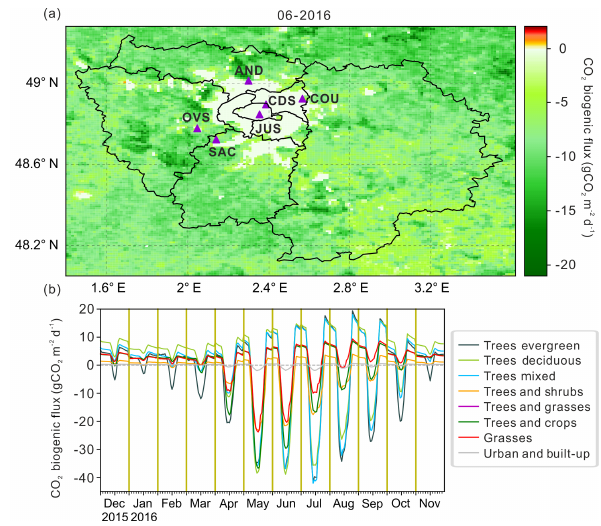
Figure 4. (a) Daytime (06:00–18:00UTC) average of CO 2 biogenic flux (NEE) in June 2016; (b) mean diurnal cycles of CO 2 biogenic flux (NEE) for 12 calendar months and for eight vegetation classes used in VPRM over Domain